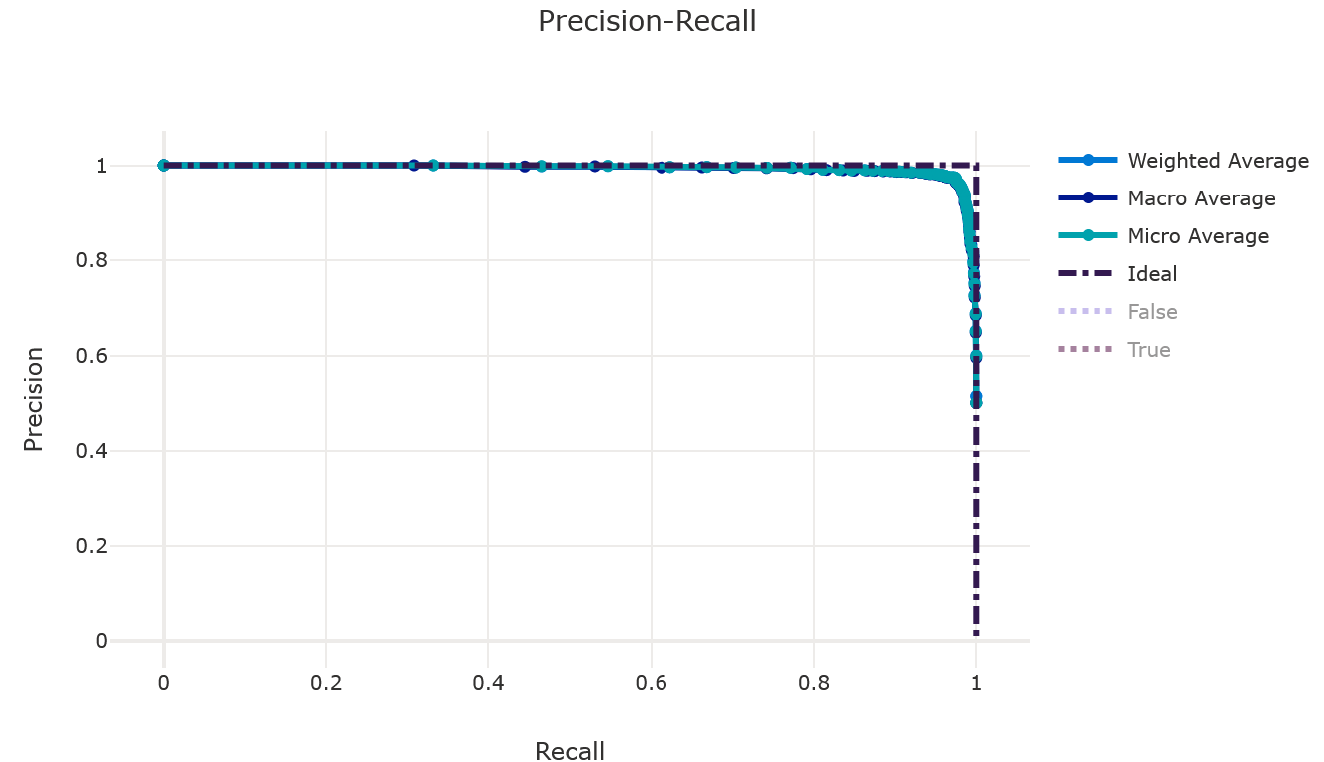
Figure 6. Receiver operating characteristic (ROC) curve. Figure 7 describes the graph with the results of the recall versus precision.